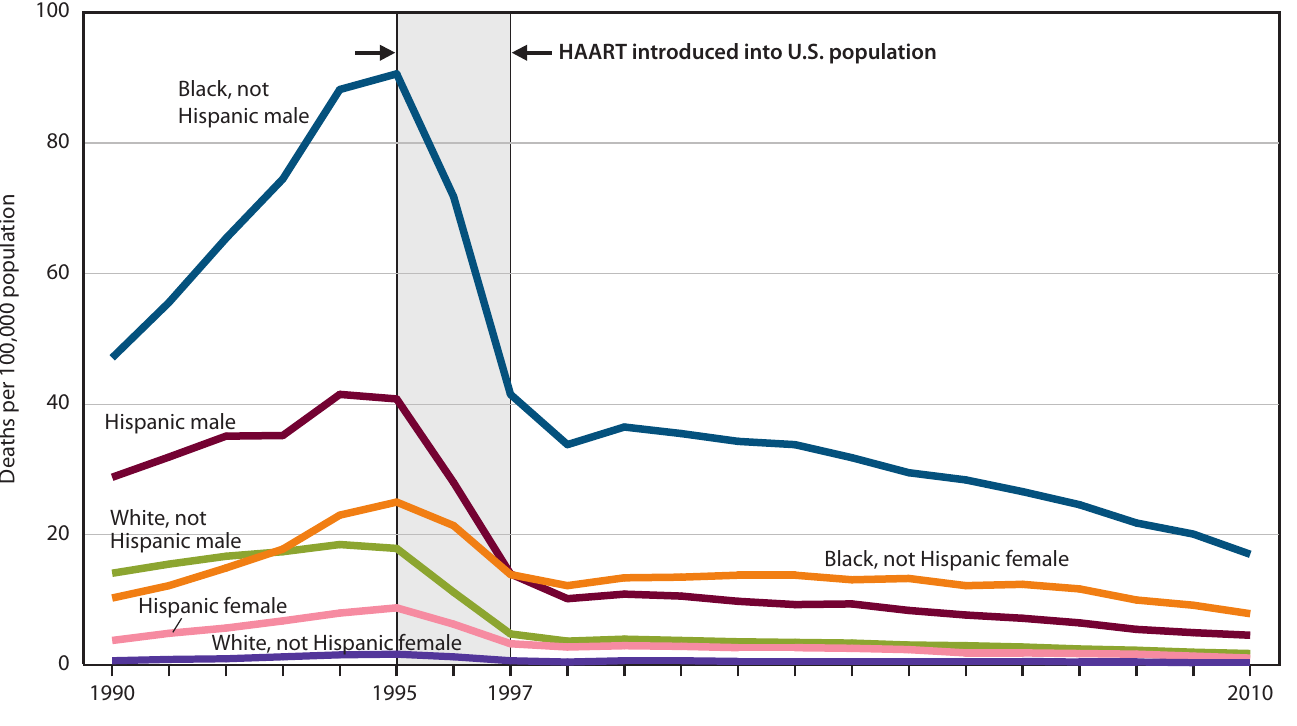
Figure 24. Age-adjusted death rates for human immunodeficiency virus (HIV) disease for all ages, by sex and race